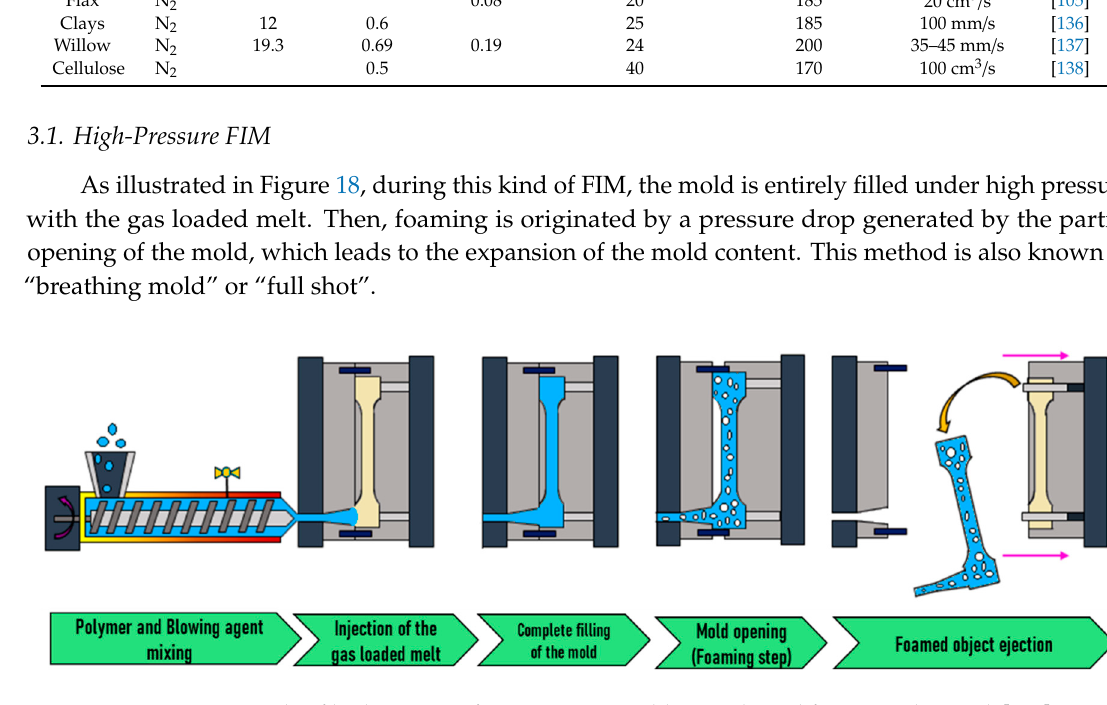
Figure 18. Principle of high pressure foam injection molding. Adapted from Standau et al. [132].